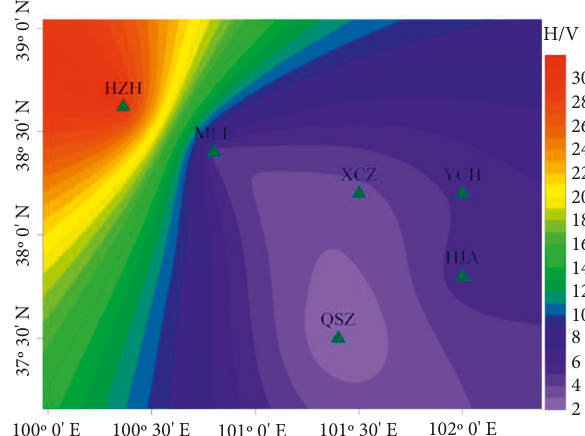
Figure 10: Contour map of HVSR in study area.